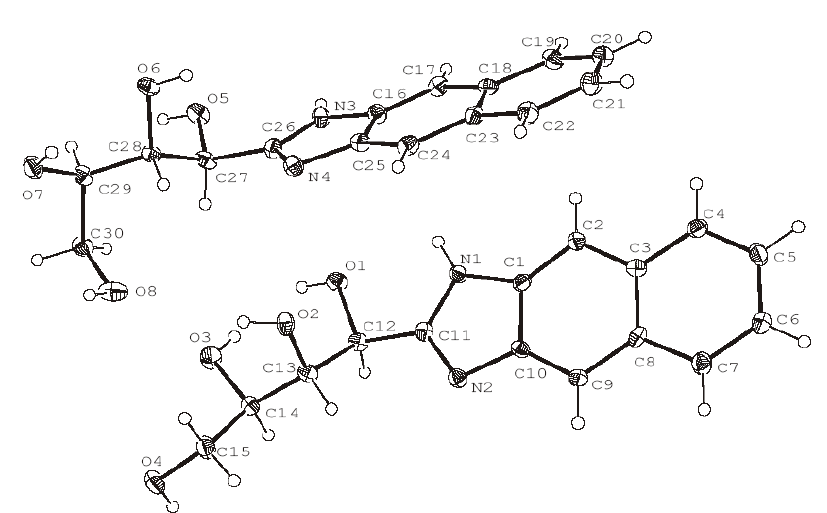
Figure 2. X-ray structure of the xylo-naphthimidazole.